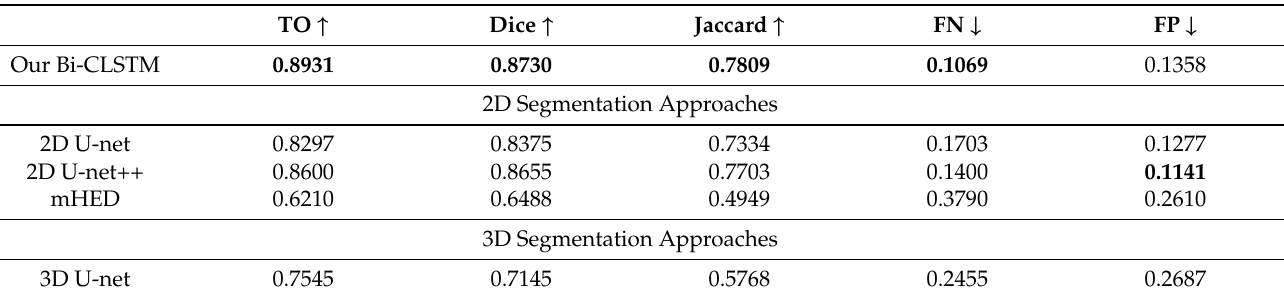
Table 1. Thrombus ROI segmentation result comparison of our Bi-CLSTM method with three